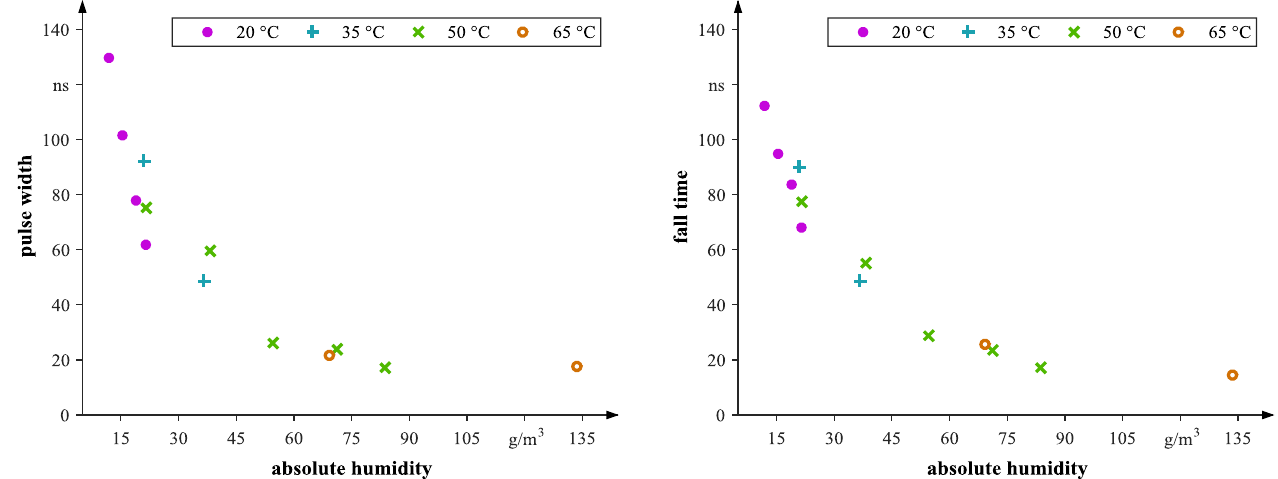
Fig. 7. Medians of the pulse width (left) and the fall time (right) for positive corona discharges in dependence of the absolute